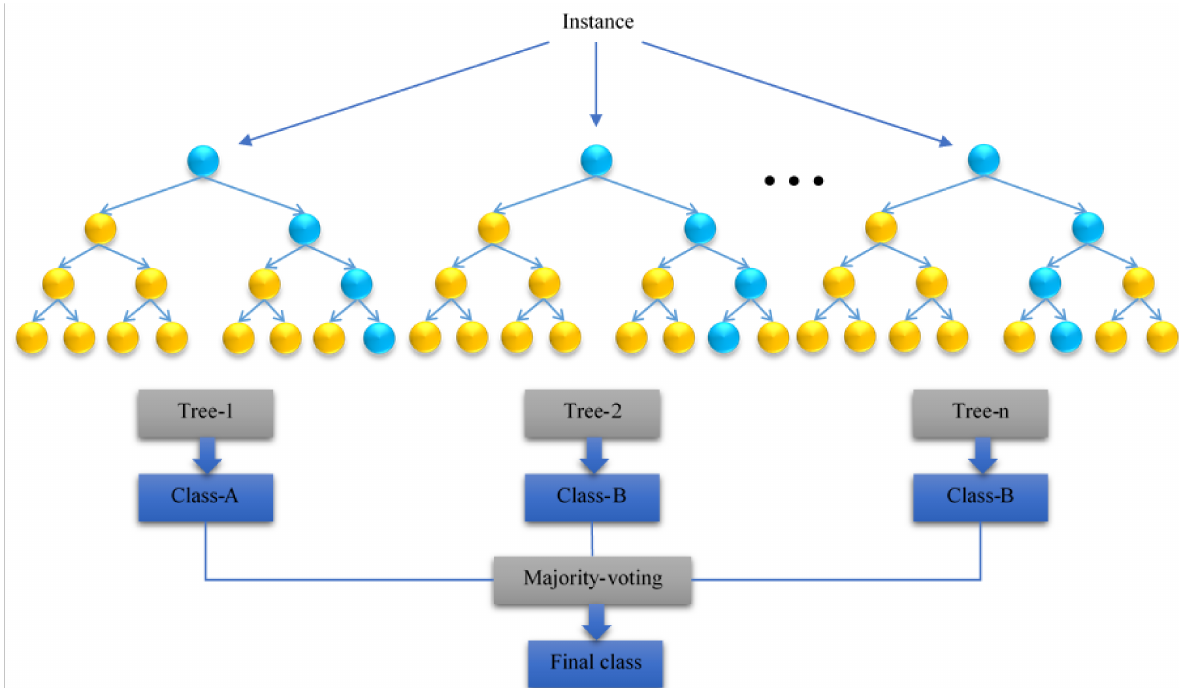
Figure 3. Flowchart of the random forest and decision tree